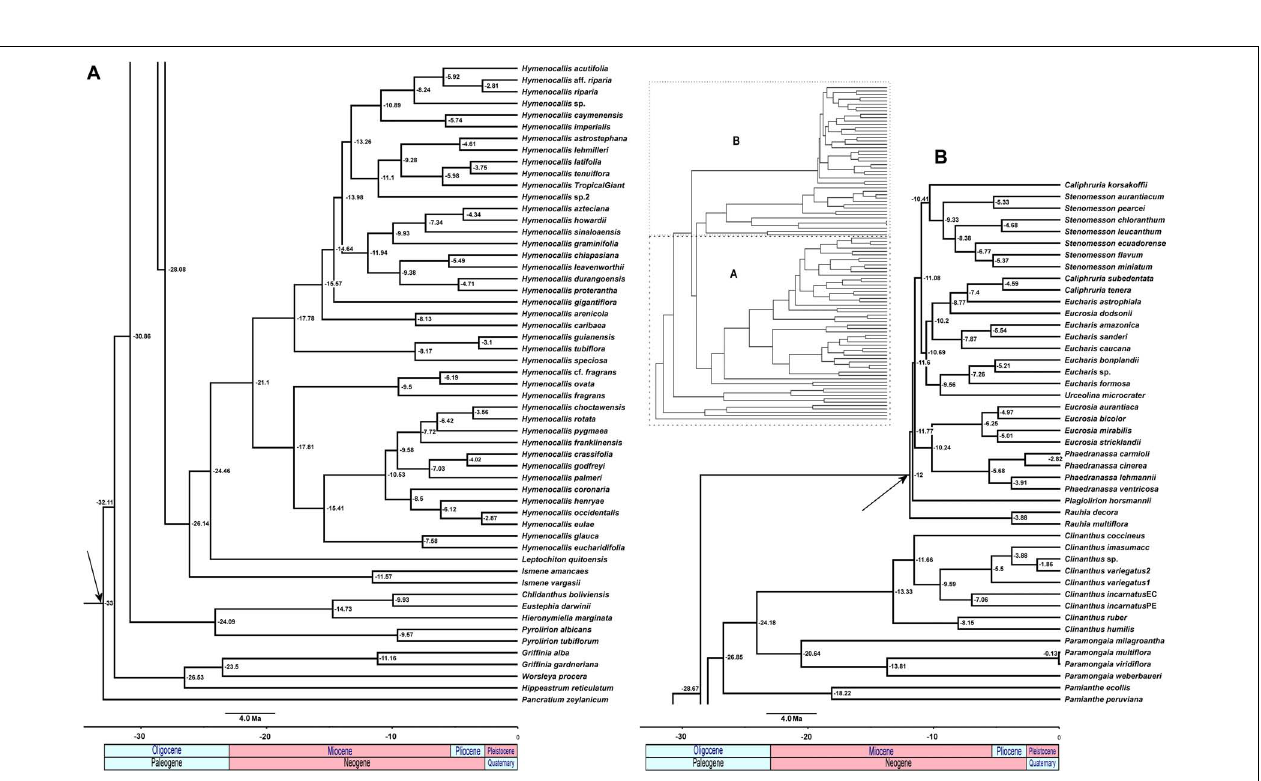
FIGURE 9 | Relaxed penalized likelihood chronogram of the Andean tetraploid clade using the chronos function of APE with the best 90% taxon coverage supermatrix tree found by RAxML. Arrows indicate calibration nodes used in the analysis. Numbers along branches are millions of years before present. The entire tree is shown in the inset, with subclades (A) and (B) magnified for clarity.